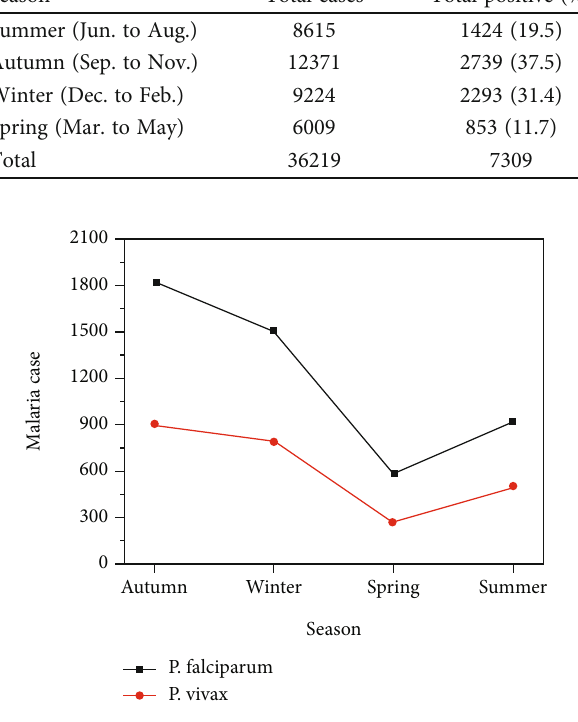
Figure 2: Seasonal prevalence of malaria by Plasmodium types at MHC, northwest Ethiopia, from 2015-2019.